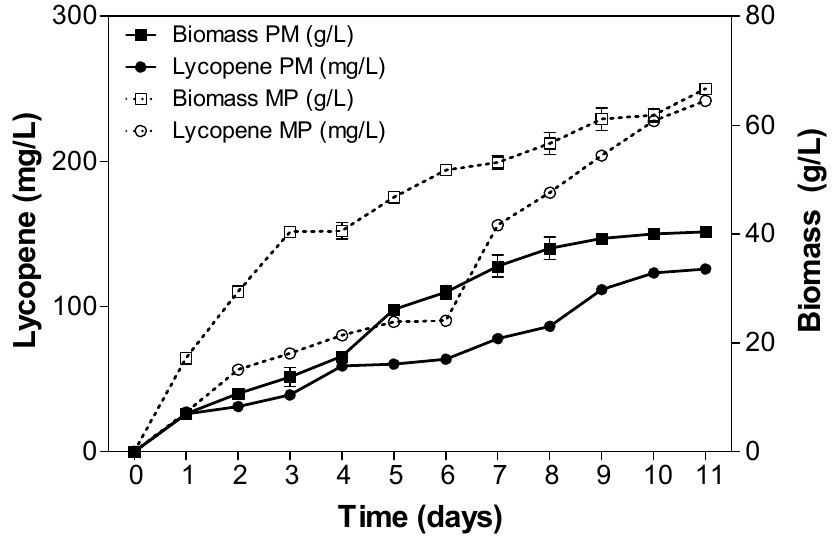
Figure 2. Fed-batch cultivation of Po1f-1312E + 1269IB for lycopene and biomass